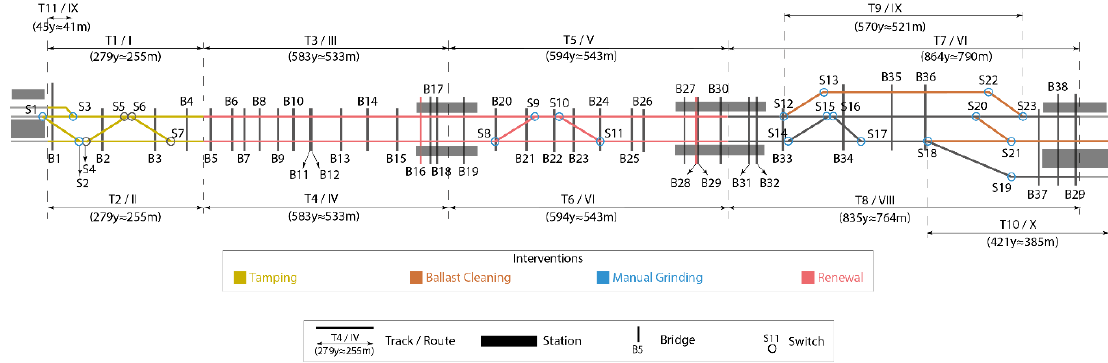
Figure 5. Optimal intervention program. Table 8. Optimal intervention program determined using the network flow model.